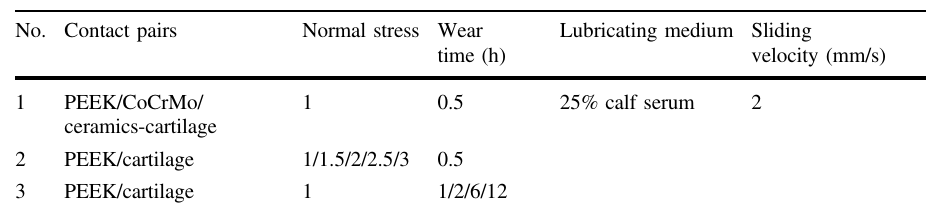
Table 3 Experimental parameters of bio-friction